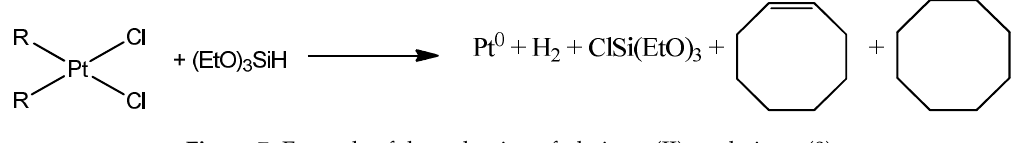
Figure 7. Example of the reduction of platinum(II) to platinum(0).